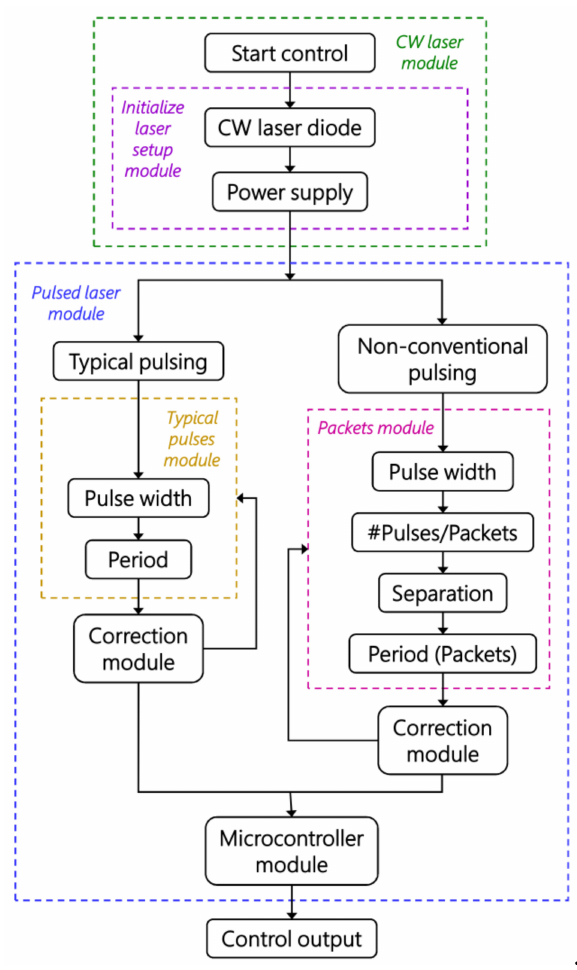
Figure 1. Block diagram of the pulsed laser based on a